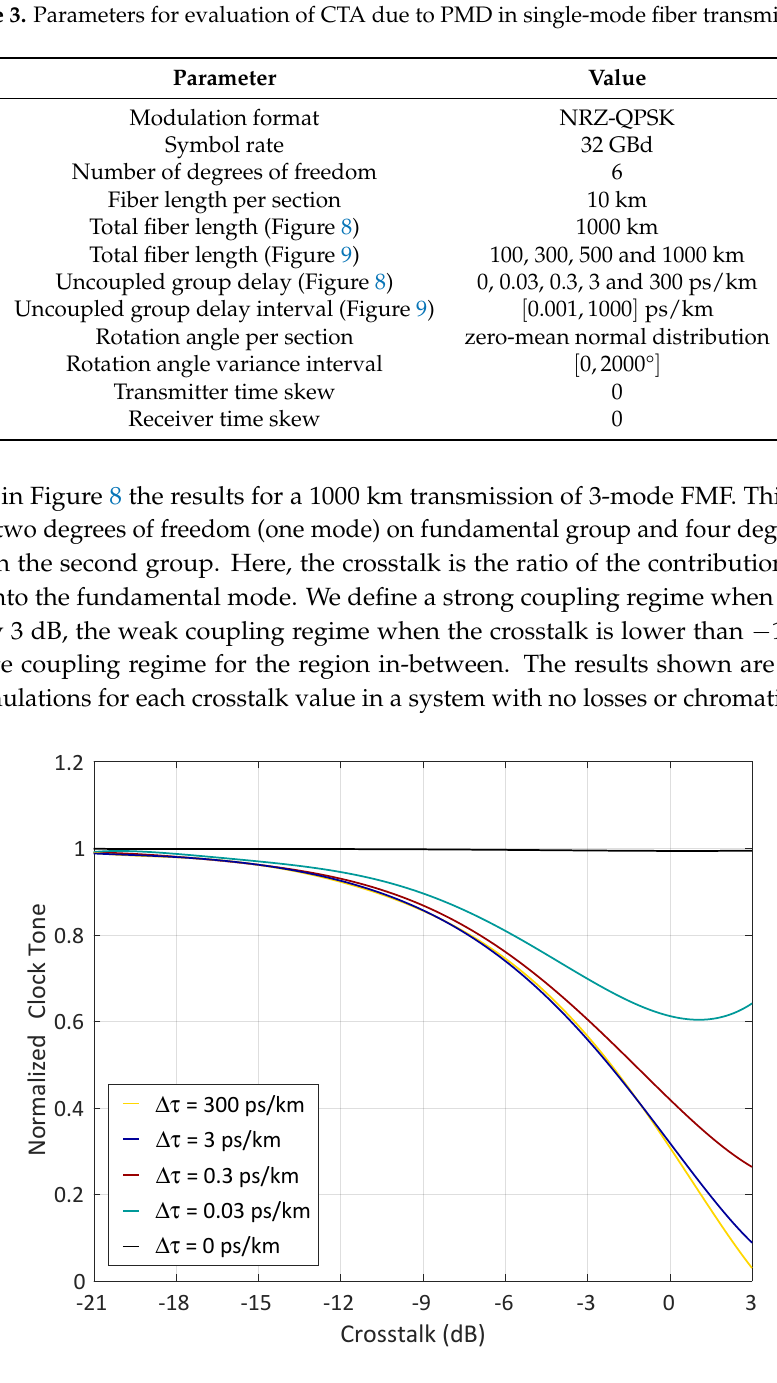
Figure 8. Normalized clock tone amplitude as a function of crosstalk between mode groups in a 1000 km transmission of a 3-mode FMF for different values of uncoupled group